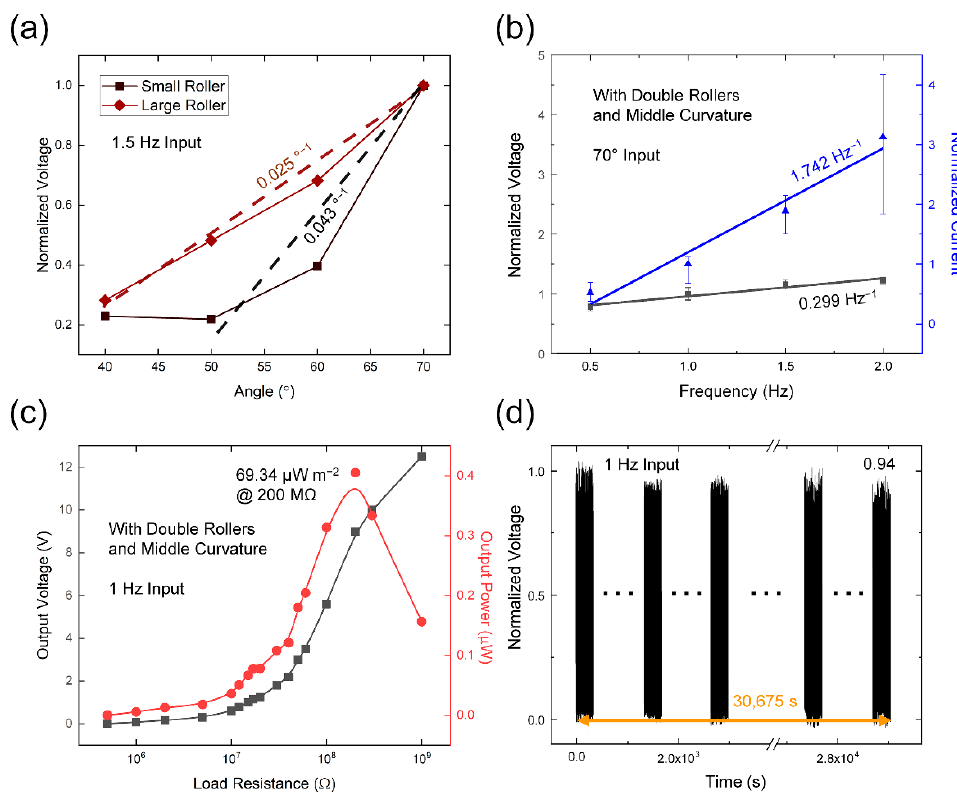
Figure 4. Electrical output characteristics of the DR-TENG. Normalized voltages with ( a ) different angular displacement and ( b ) different frequency. ( c ) Output power with both double rollers and middle curvature case. ( d ) Durability test with 8.5 h operation.